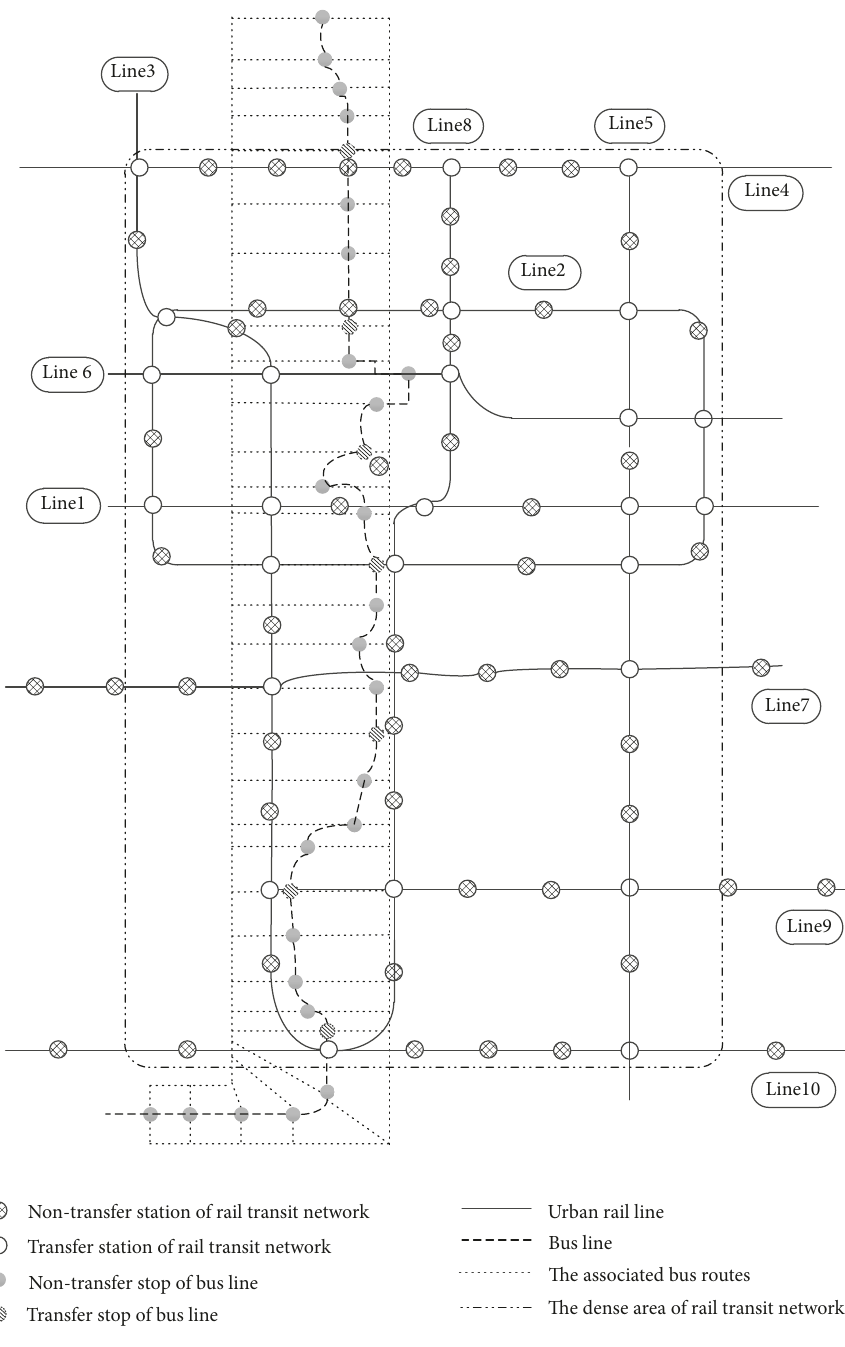
Figure 4: The public transport competition network in the case. Table 3: The different scenarios and the optimal 𝑓 𝜒